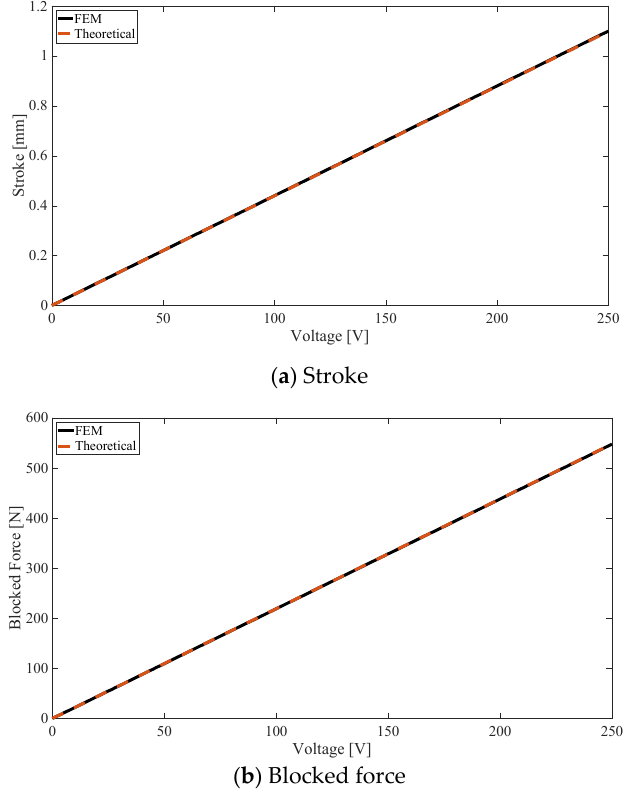
Figure 10. Actuator static behavior.